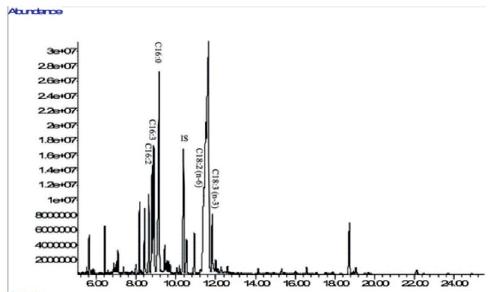
Fig. 5b. GC-MS chromatograms of FAME derived from freeze-dried biomass of freshwater green algae Chlorella sp. Carolina-15-2069 (see Table 2 for peak identification). * Heptadecanoic acid (C17:0) was used as an internal